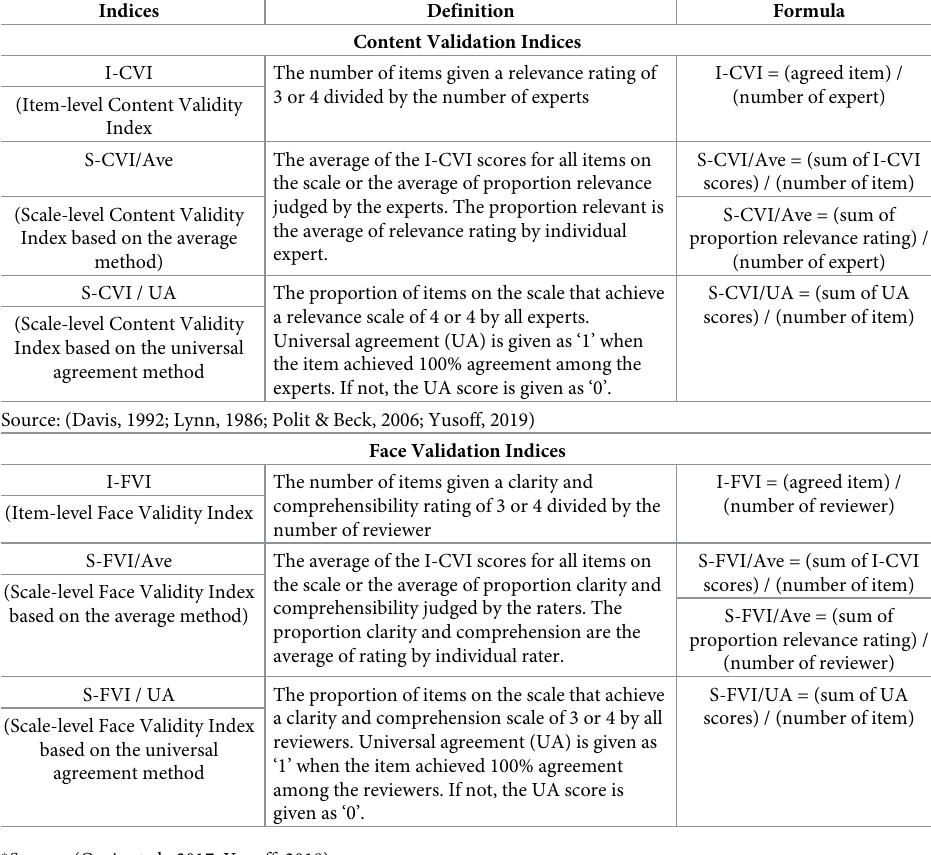
Table 1. Definition and formula for content validation indices and face validation